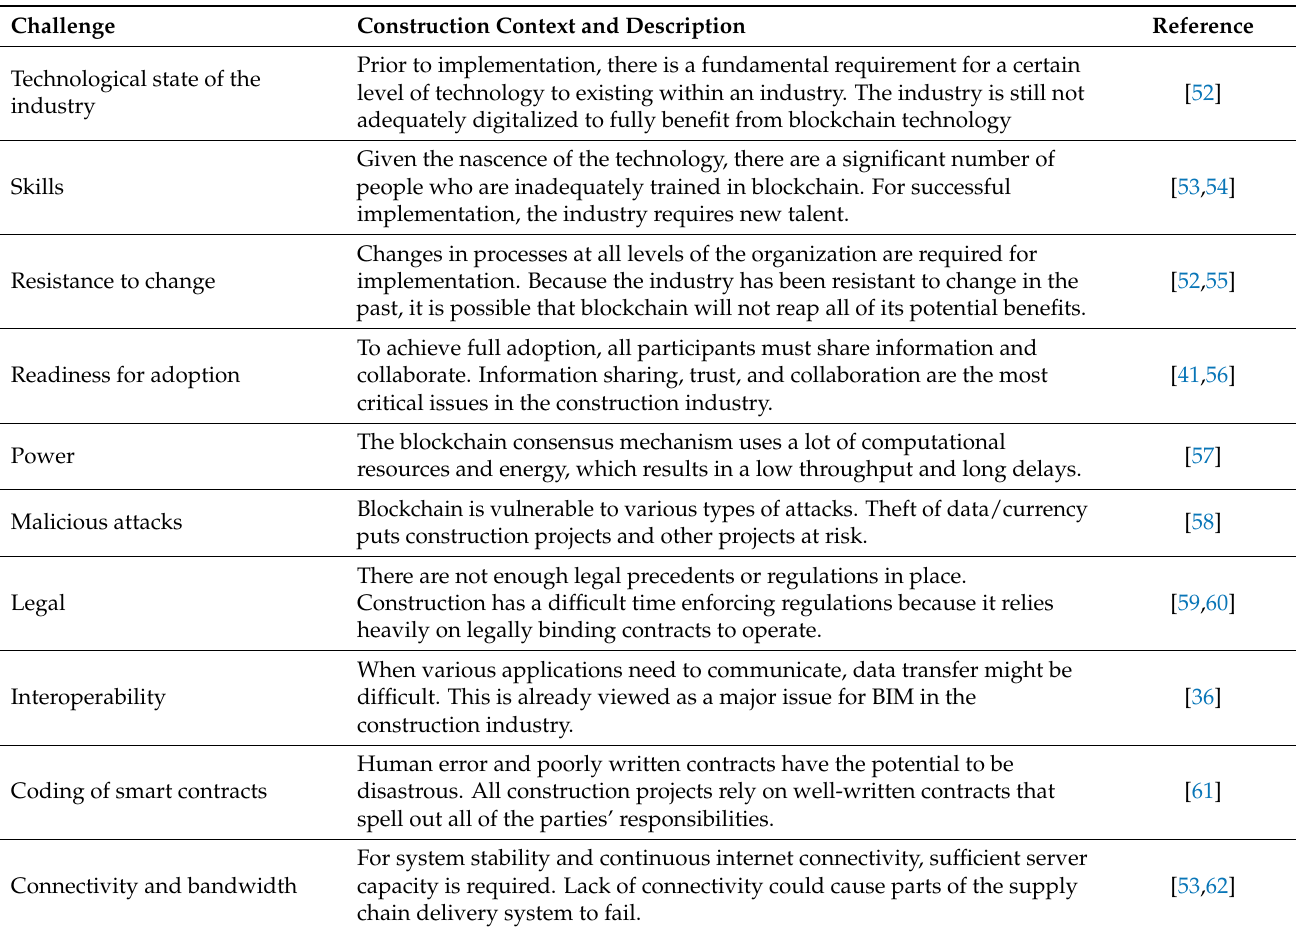
Table 2. Blockchain implementation challenges in the construction